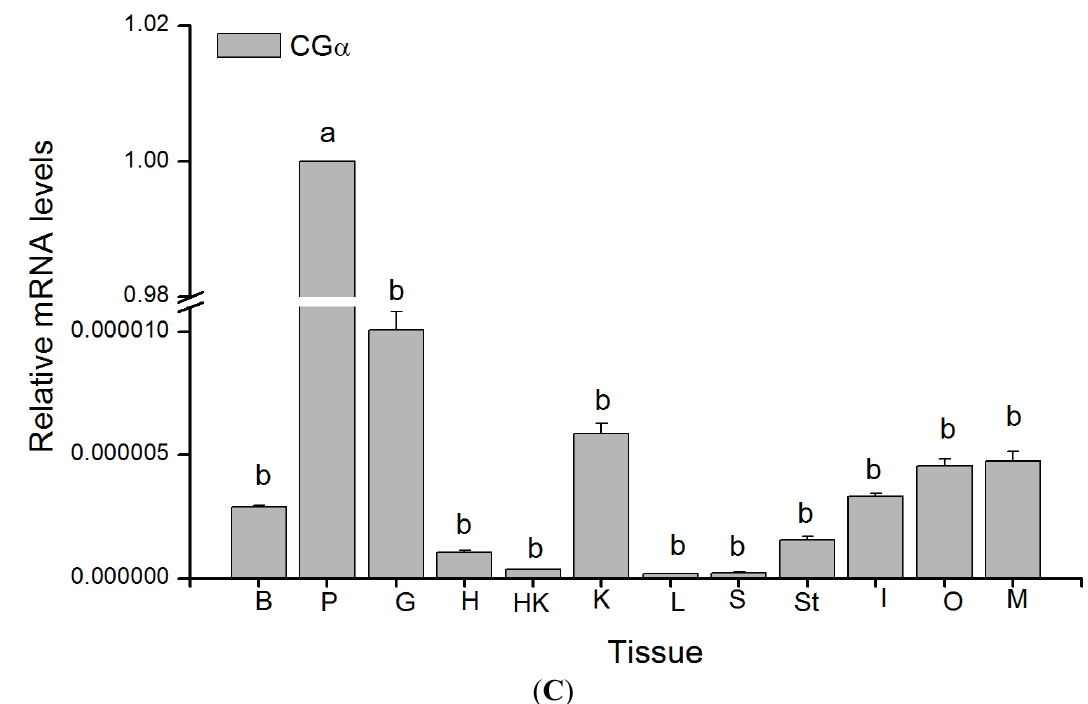
Figure 6. Relative mRNA expression levels in maturing female C. semilaevis tissues. The abundance of FSH β ( A ), LH β ( B ) and CG α ( C ) transcripts, respectively, was determined by qRT-PCR and normalized to 18S ( n = 4). Each bar represents the mean ± SE. Tissues marked by the different letters differing significantly from each other ( p < 0.05). B: